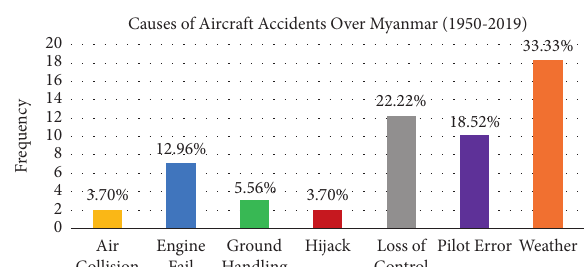
Figure 8: Causes of aircraft accidents over Myanmar